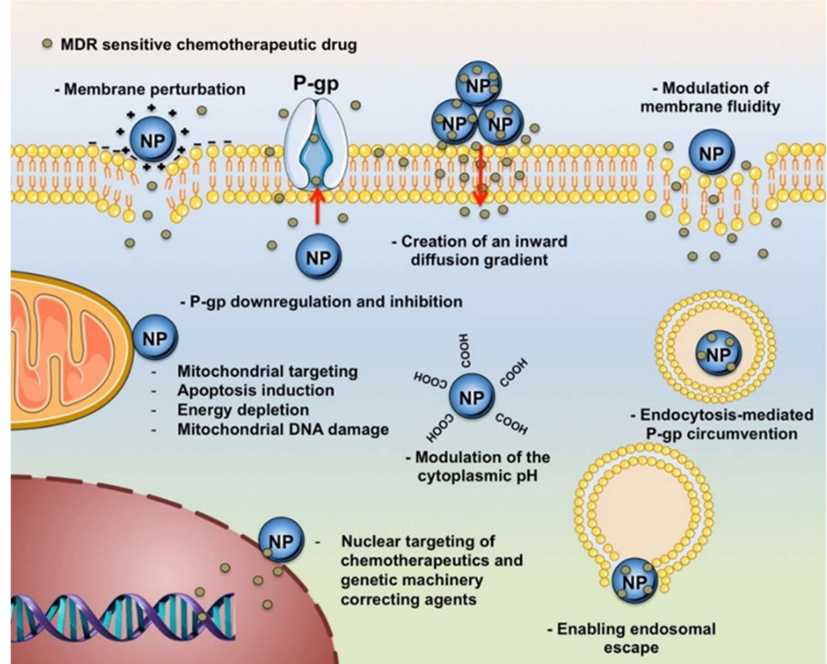
Figure 1. General representation of the main MDR reversal mechanisms by nanoparticle systems (NP). Reproduced with permission from [4]. Copyright Elsevier